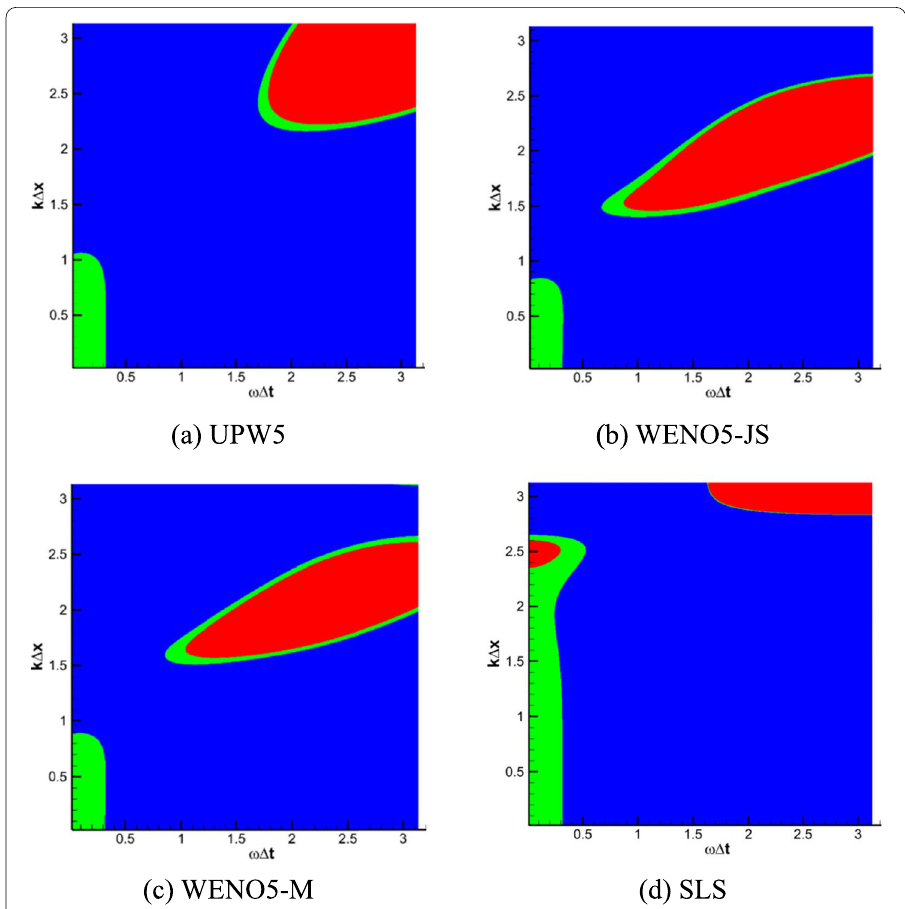
Fig. 3 Distribution of V g / c in the k Δ x vs. ω Δ t space for different spatial schemes. RK 4 is used for the time discretization, and σ 0.01. The green region represents the range 0.95–1.05, the red region represents the = range > 1.05, and the blue region represents the range <